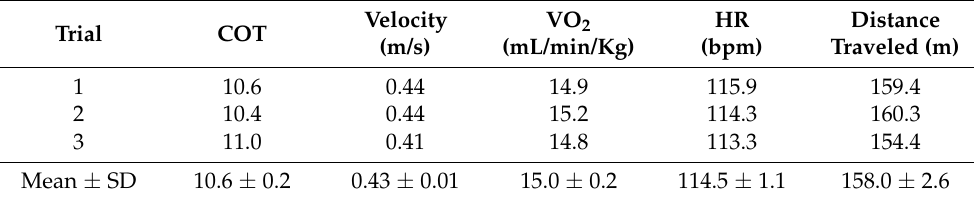
Table 5. Metabolic cost estimation following the 6 min walking test wearing non-powered EGO.